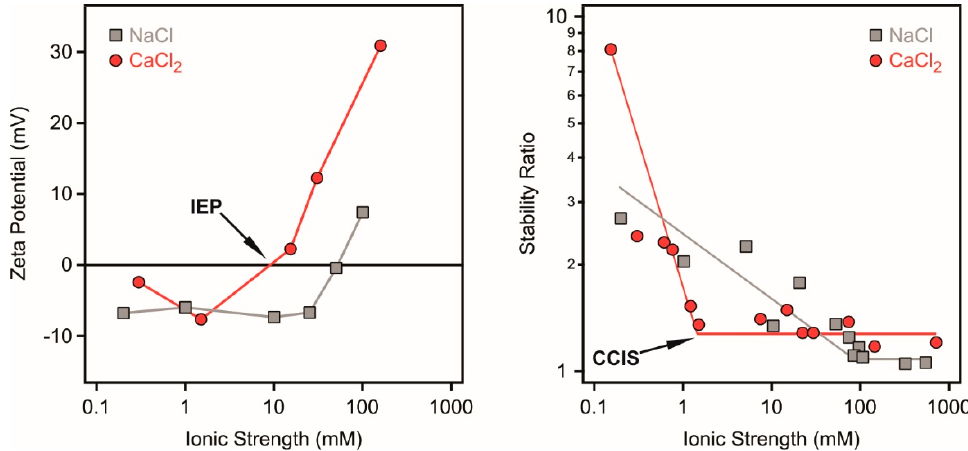
Figure 5. Zeta potential ( left ) and stability ratios ( right ) of titania particles as a function of the ionic strength adjusted by NaCl or CaCl 2 . The data were reproduced from Reference [71].